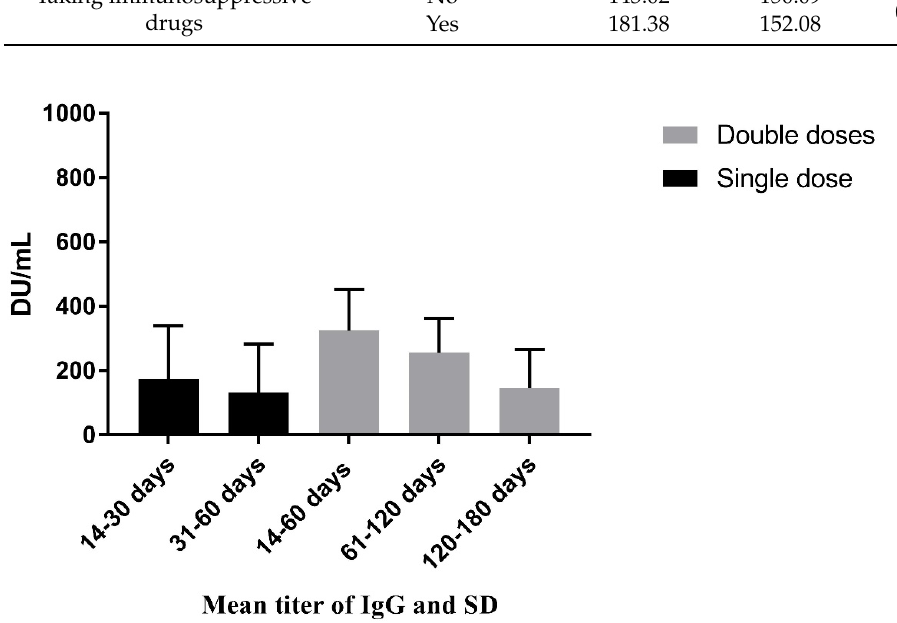
Figure 2. Evaluation of the time effects of the vaccines’ mean difference in the quantitative anti ‐ SARS ‐ CoV ‐ 2 antibody (IgG) in serum samples.